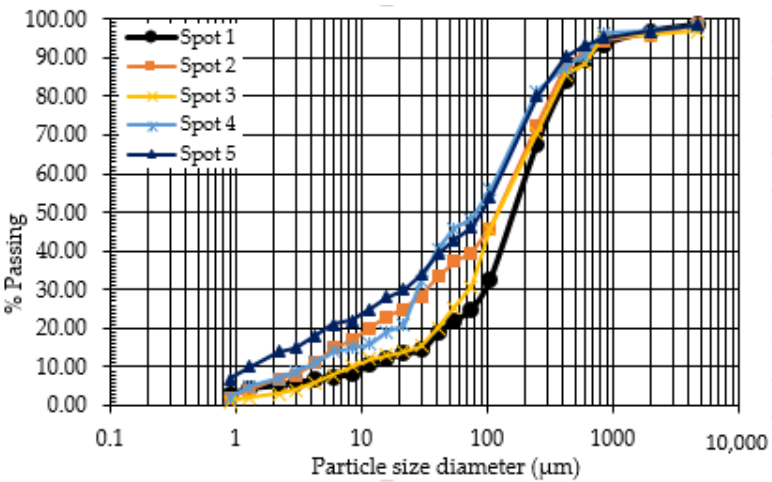
Figure 5. Particle size distribution of Lowari Tunnel dust collected at selected spots.